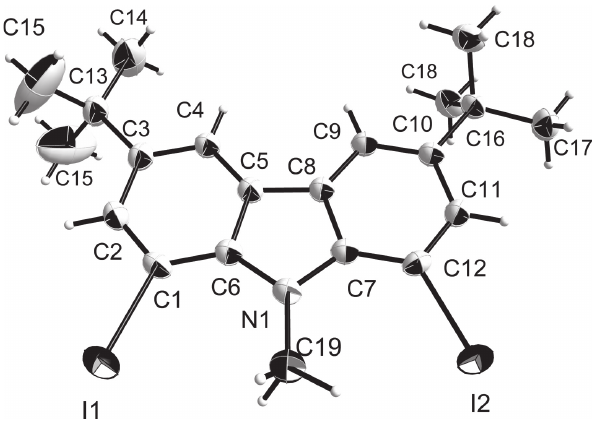
Table 2: Fractional atomic coordinates and isotropic or equivalent isotropic displacement parameters (Å 2